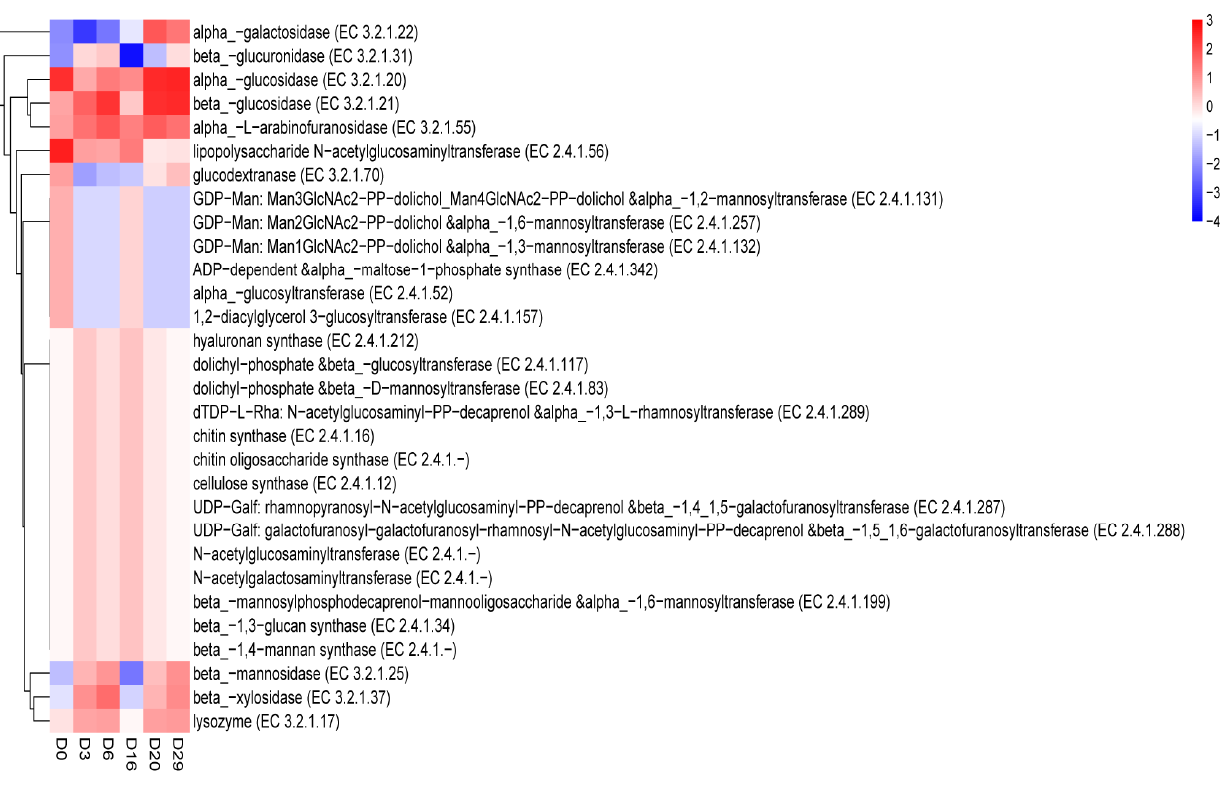
Figure 6. Cluster heatmap of functional abundance during Daqu fermentation (base on CAZy database) ( p < 0.05).